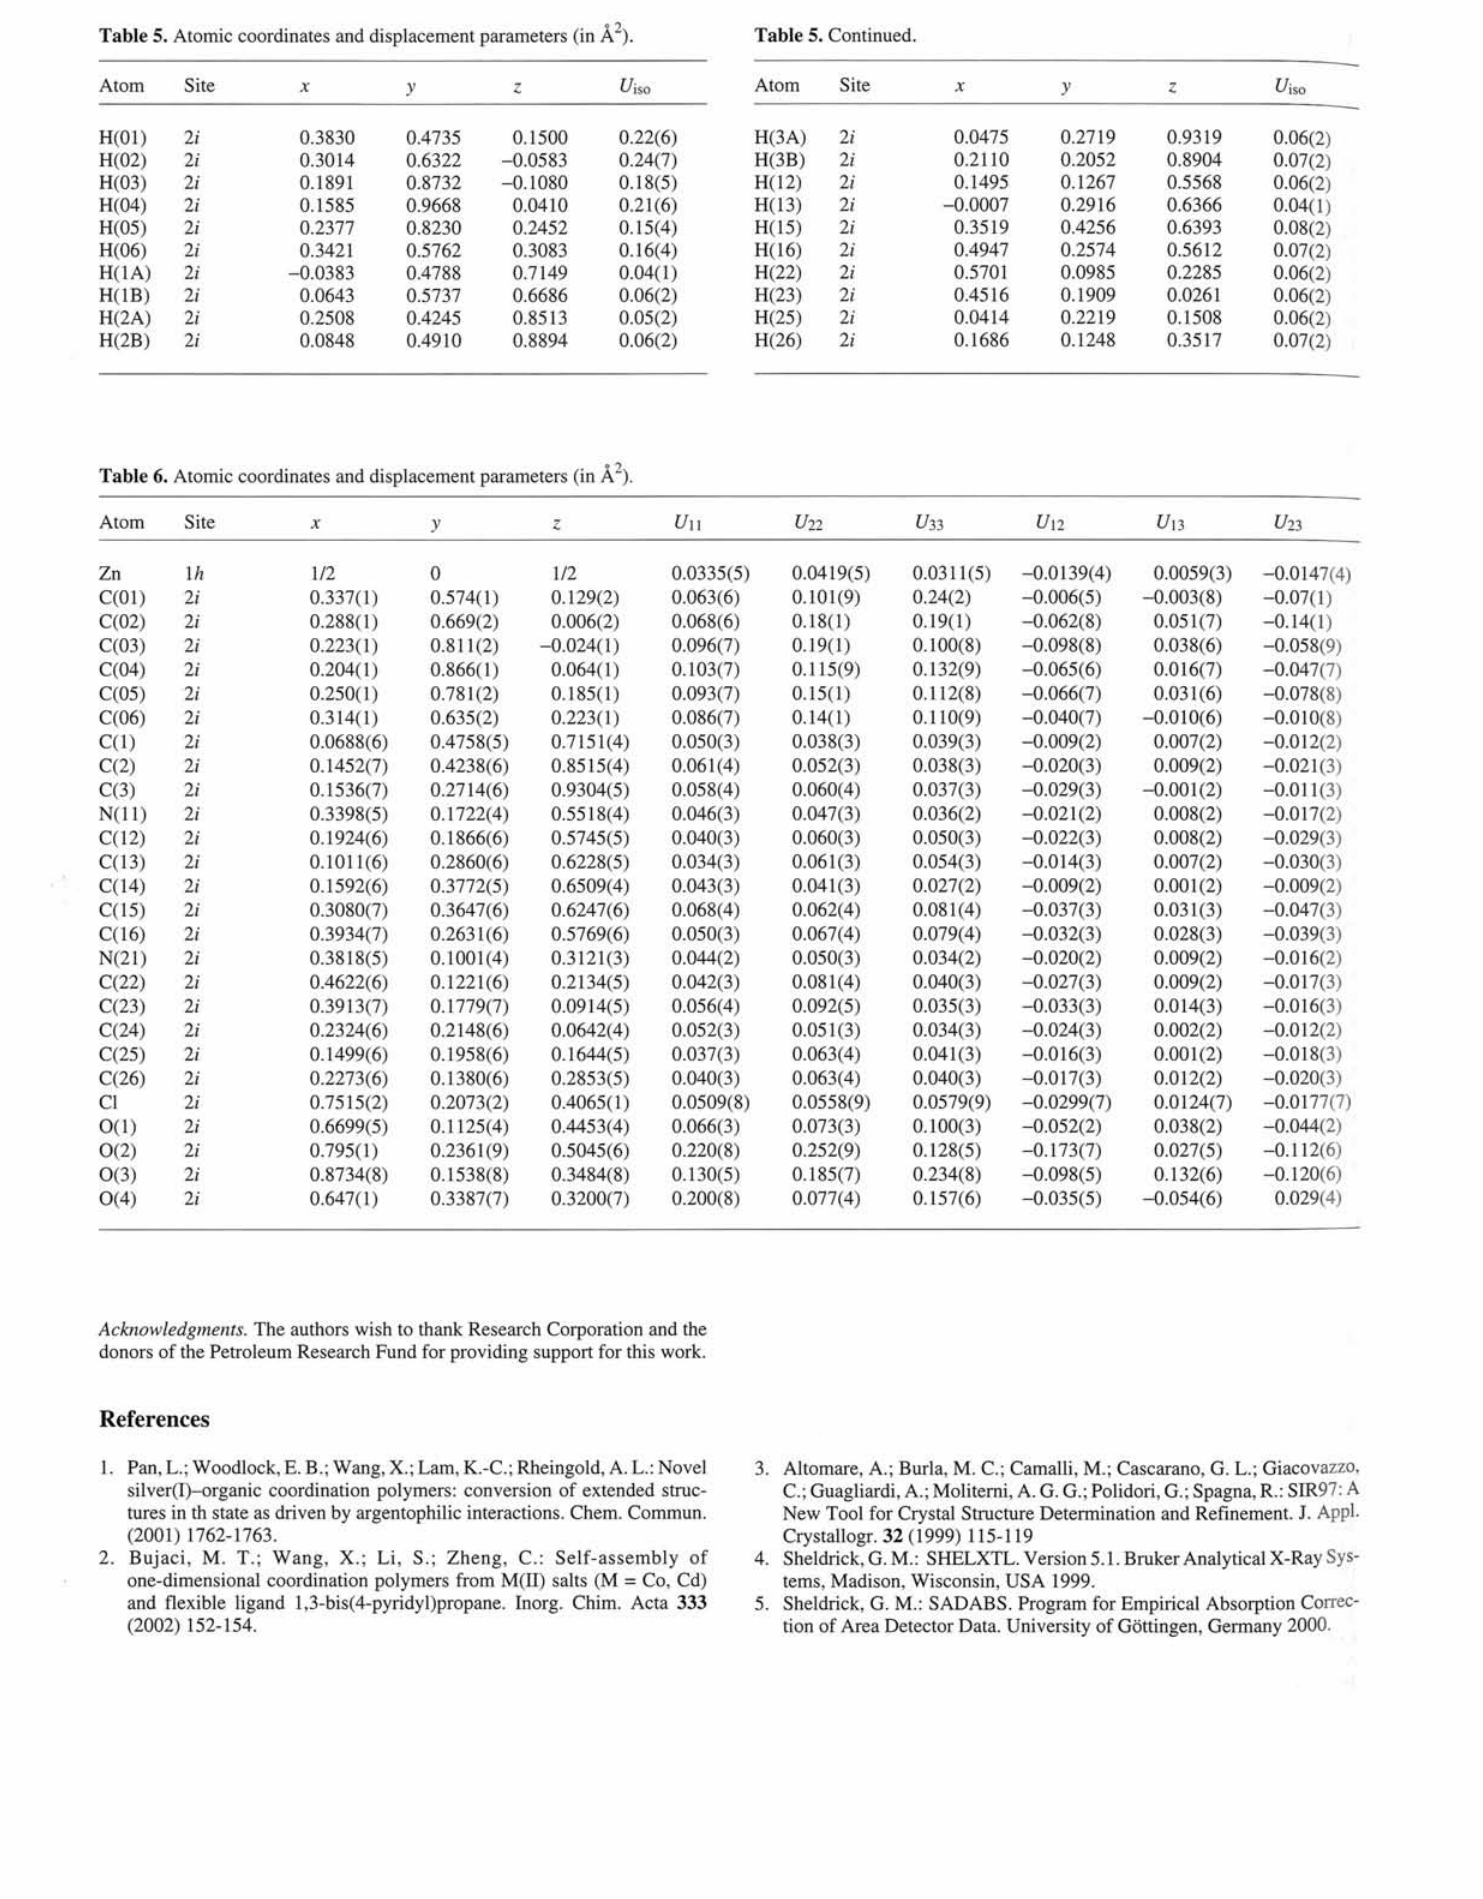
Table 5. Atomic coordinates and displacement parameters (in Â 2 ).